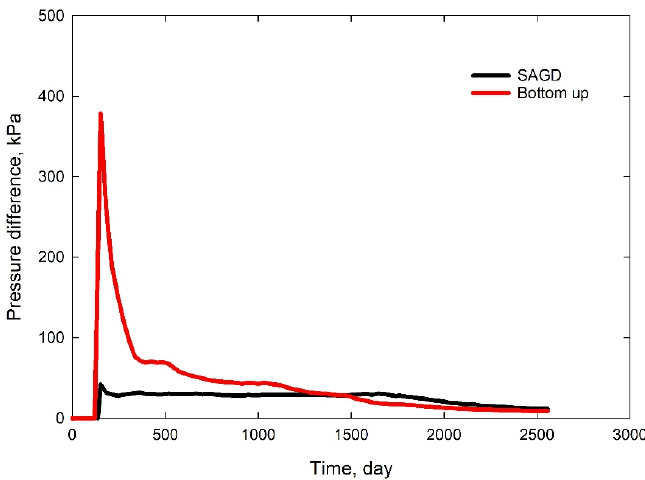
Figure 7. Pressure difference between injector and producer in bottom-up pressure drive and SAGD processes indicating the large pressure difference in the bottom-up assisted pressure drive.